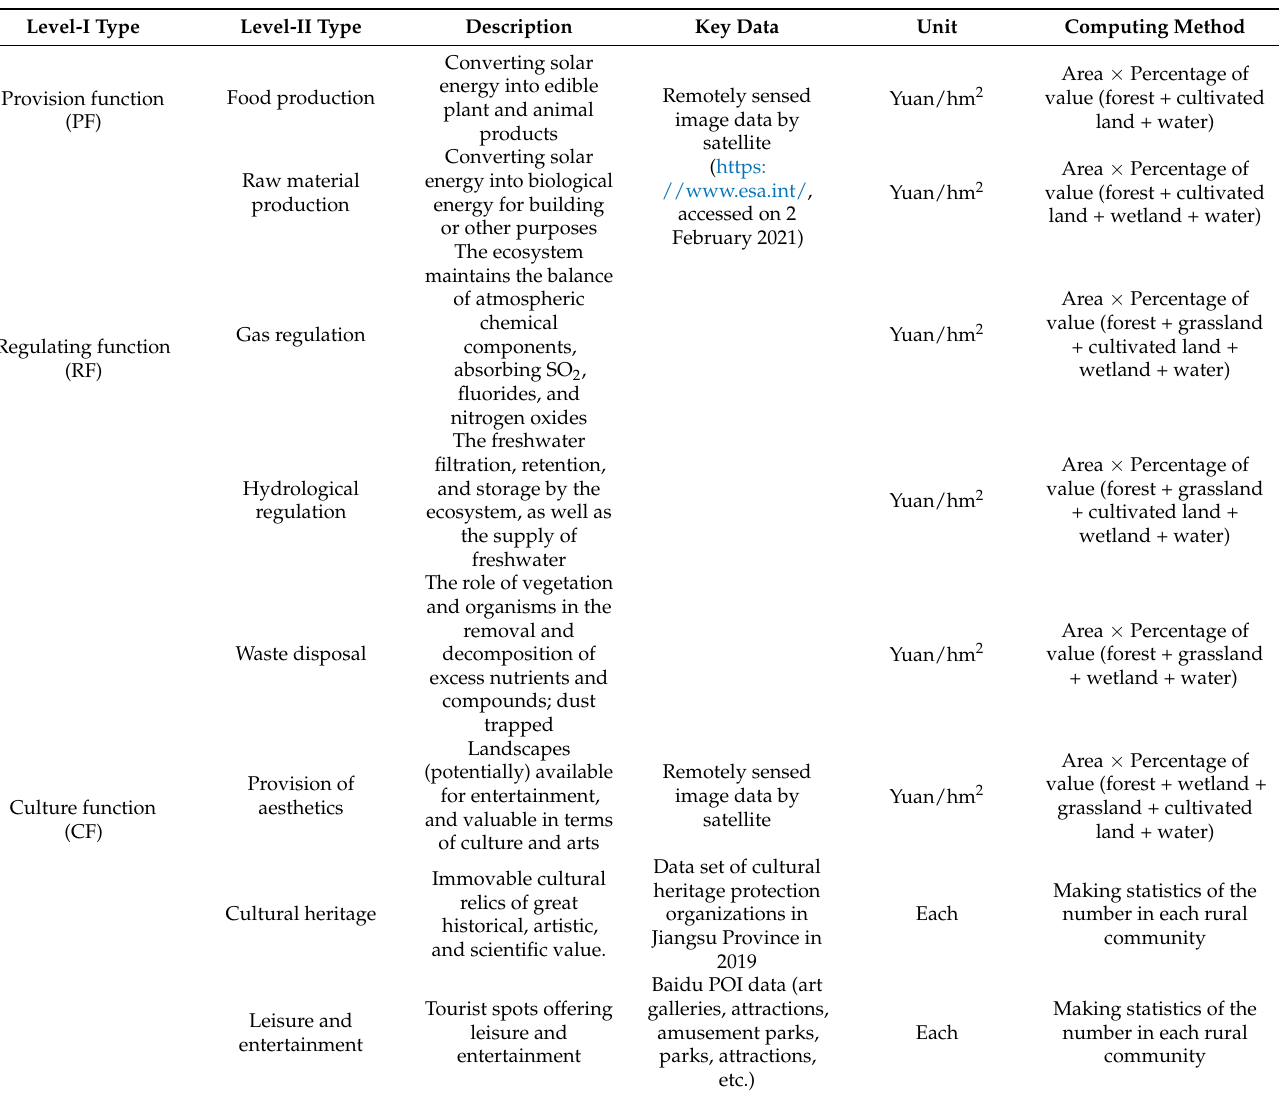
Table 2. Landscape function and its computing